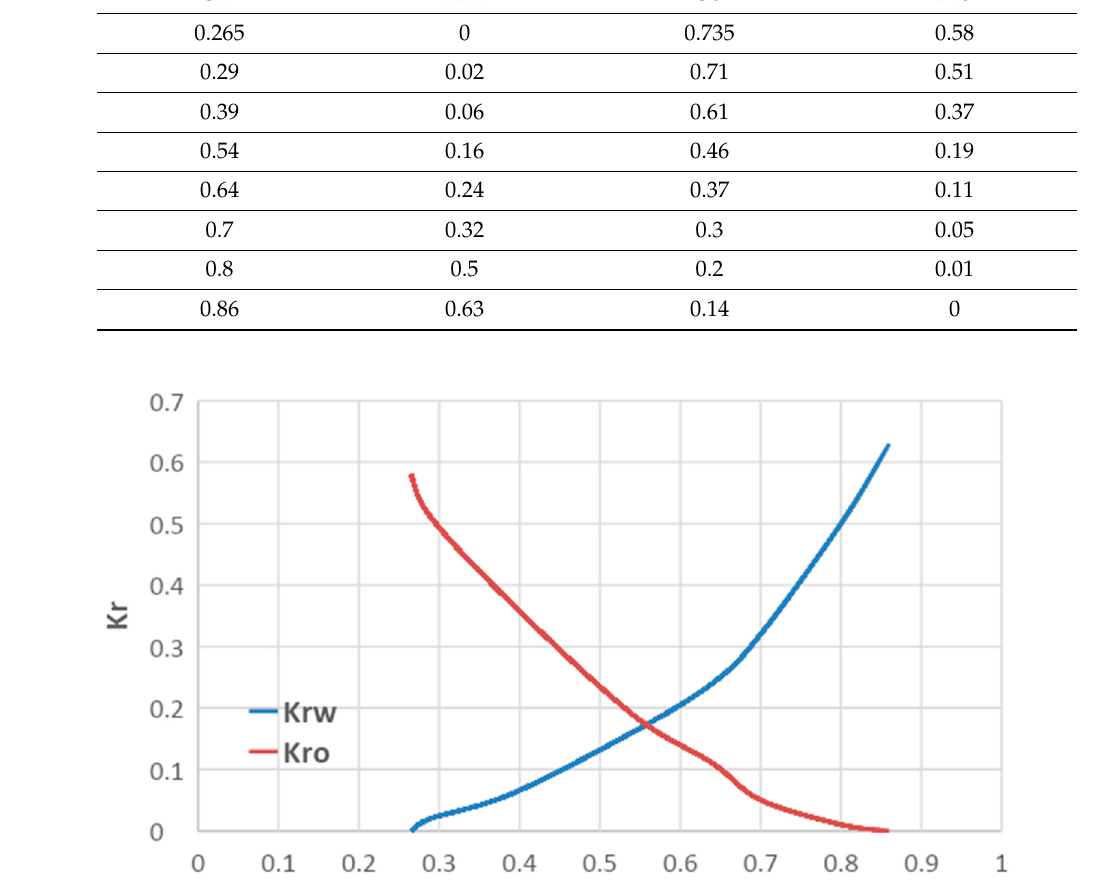
Table A6 . Relative Permeabilities and Saturations.